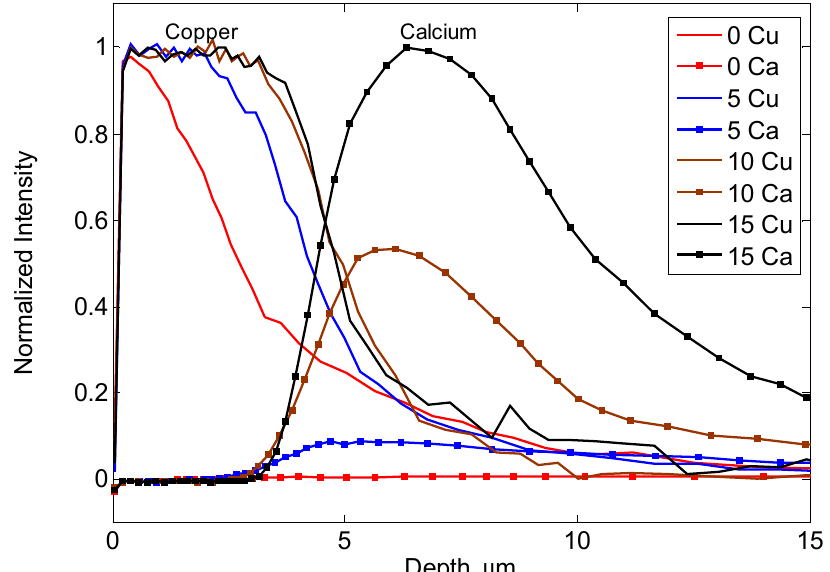
Figure 7. Elemental (copper and calcium) depth profiles of cyan toner printed on an uncoated and on three coated papers (coat weights 5,10,15 gm − 2 ), determined from LIBS data. In the figure, ablation depths are transformed into absolute length scale ( µ m) along the horizontal axis according to results shown in Figure 3. The vertical axis denotes normalized intensity. We observed zero calcium signal in the printed base paper.